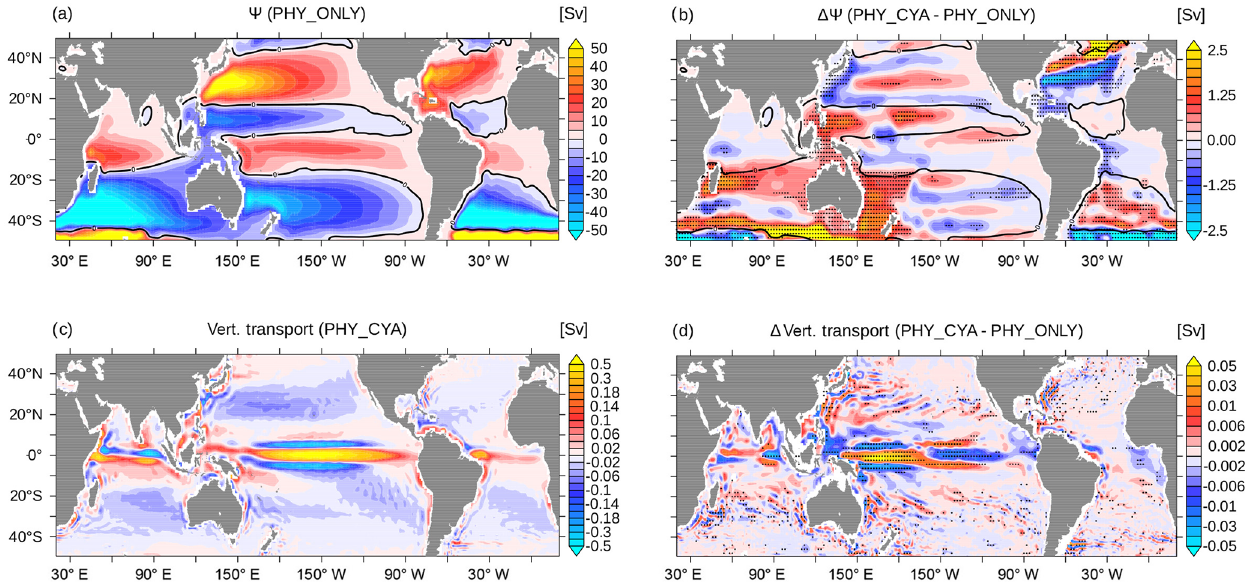
Figure 6. (a) Climatological mean barotropic stream function (cid:57) (Sv, sverdrup) in PHY_ONLY. The zero isoline is overlaid in black. (b) Difference in the climatological mean (cid:57) (Sv) between PHY_CYA and PHY_ONLY. The zero isoline of PHY_ONLY is overlaid in black. (c) Climatological mean vertical transport in the upper 100m (Sv) in PHY_ONLY. Note the nonlinear color scaling with 0.01Sv between − 0 . 2 and 0.2Sv and 0.1Sv for the remaining range. (d) Difference in the climatological annual mean vertical transport in the upper 100m (Sv) between PHY_CYA and PHY_ONLY. Note the non-linear color scaling with 0.001Sv between − 0 . 01 and 0.01Sv and 0.01Sv for the remaining range. The dotted areas in (b) and (d) indicate statistically significant anomalies at the 90% confidence level (student’s t